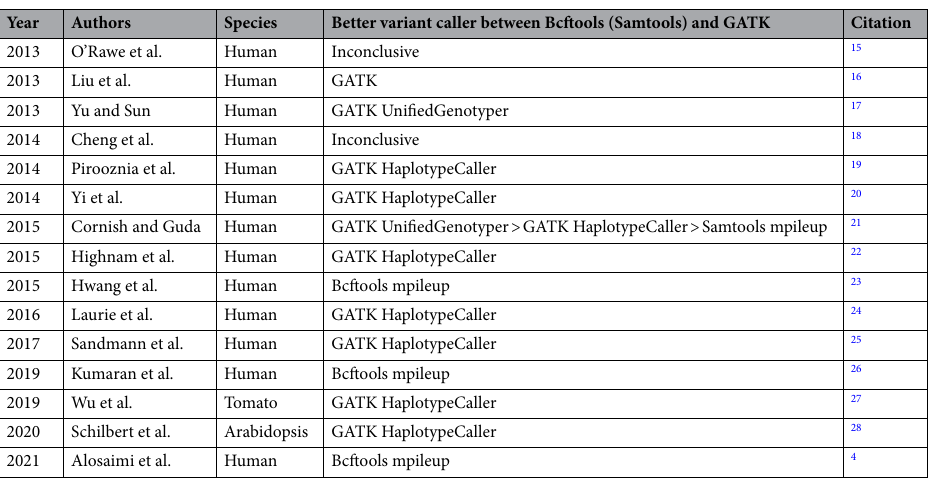
Table 1. Studies comparing the performance of variant calling between GATK and